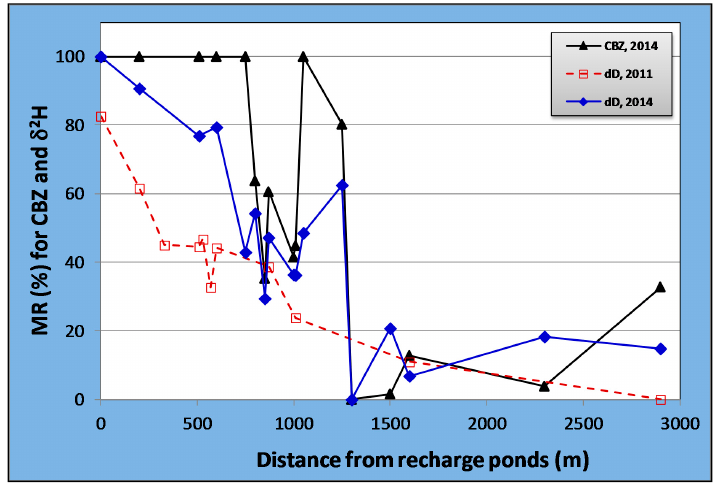
Figure 6. Mixing Ratios (MR) in recovery and observation wells vs. distance from the recharge ponds. MRs were calculated from CBZ results in the 2014 campaign (represent also the 2010–2011